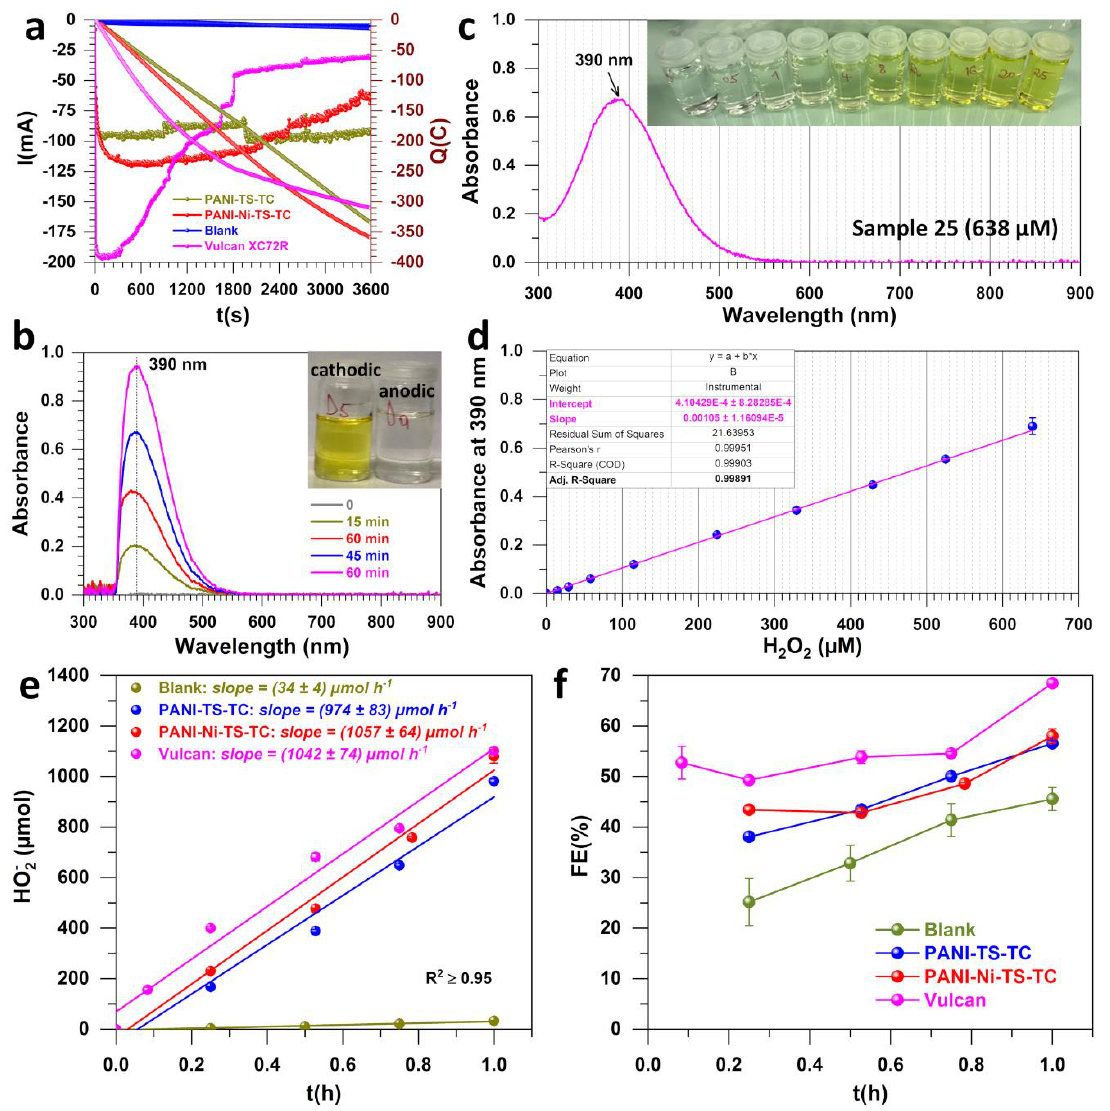
Figure 4. Bulk electrolysis and electroanalysis. ( a ) Electrical charge passed during the potentiostatic electrolysis at an applied potential of 0.6 V RHE (iR-uncorrected). ( b ) UV-vis spectra of the anodic compartment at different times of the electrolysis (aliquot was neutralized by sulfuric acid before addition of potassium titanium oxalate solution). ( c ) UV-vis spectrum of hydrogen peroxide (638 µM) in the presence of sulfuric and potassium titanium oxalate solution: inset shows the color of the solution in the presence of increasing concentration of hydrogen peroxide. ( d ) Calibration curves from UV-vis assays at 390 nm and from solutions of panel ( c ). ( e ) Hydrogen peroxide productivity as quantified by the UV-vis assays. ( f ) Faradaic efficiency. The electrocatalyst loading was 0.5 mg cm −2 and the electrode size was 4 cm 2 . The blank electrode was bare carbon paper MGL370 (Fuel Cell Earth LLC). Error bars represent 1 SD (n ≥ 3).